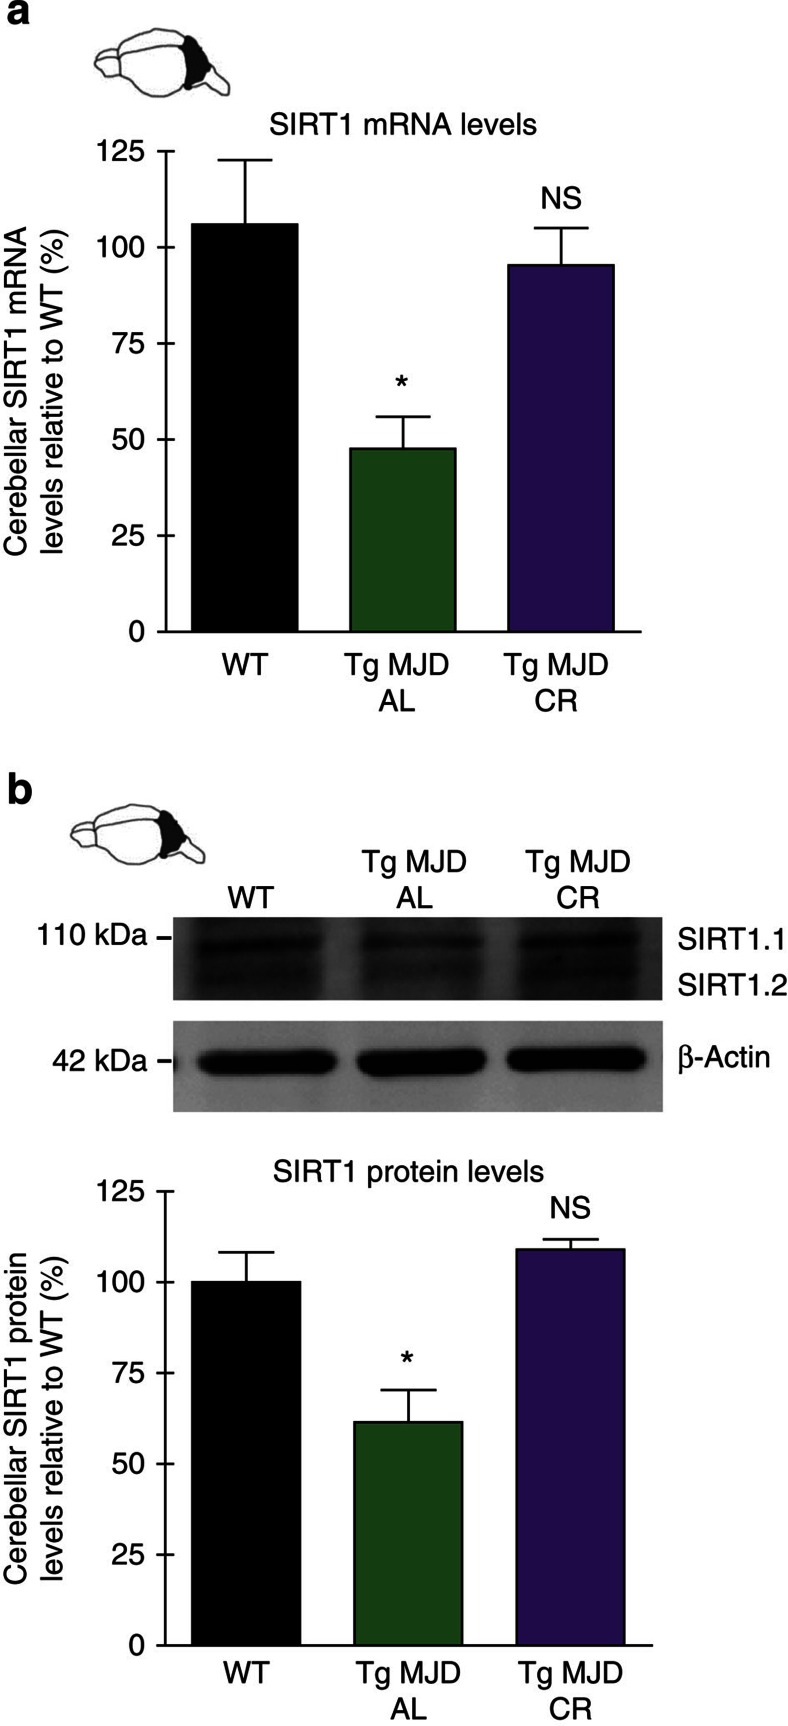
SIRT1 levels are abnormally reduced in the cerebellum of MJD Tg mouse model and CR re-establishes normal SIRT1 cerebellar levels.(a) SIRT1 is compromised in the cerebellum of Tg MJD mice. A significant decrease of 58.4±8.3% in mRNA levels of SIRT1 was detected. These results were supported by western blotting in (b). Data represent mean±s.e.m.; NS P>0.05 and *P<0.05 compared with Tg-AL. (a,b) WT n=5; Tg-AL n=5; Tg-CR n=4. SIRT1.1 (SIRT1 isoform 1) and SIRT1.2 (SIRT1 isoform 2). See also Supplementary Fig. 2.